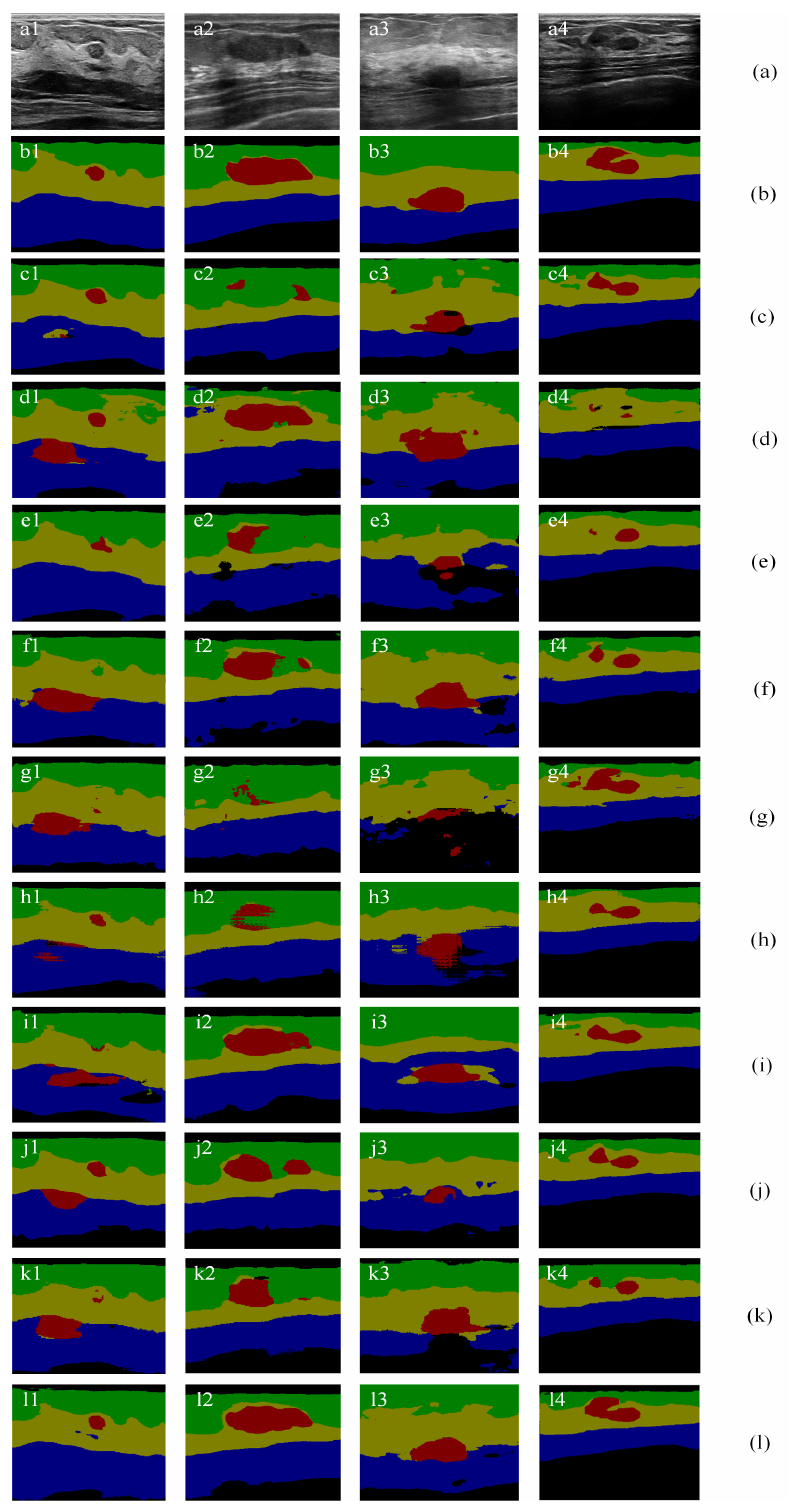
Figure 11. Multi-object semantic segmentation of BUS images: ( a ) original images; ( b ) ground truths; ( c ) results of ResNet-101 + self-attention mechanism; ( d ) results of attention U-Net; ( e ) results of ResNet-50; ( f ) results of ResNet-101; ( g ) results of Deeplab; ( h ) results of PSPNet; ( i ) results of U-Net with wavelet transform; and ( j ) results of FCN-8s; ( k ) results of SE-Net (ResNet-101); ( l ) results of the proposed